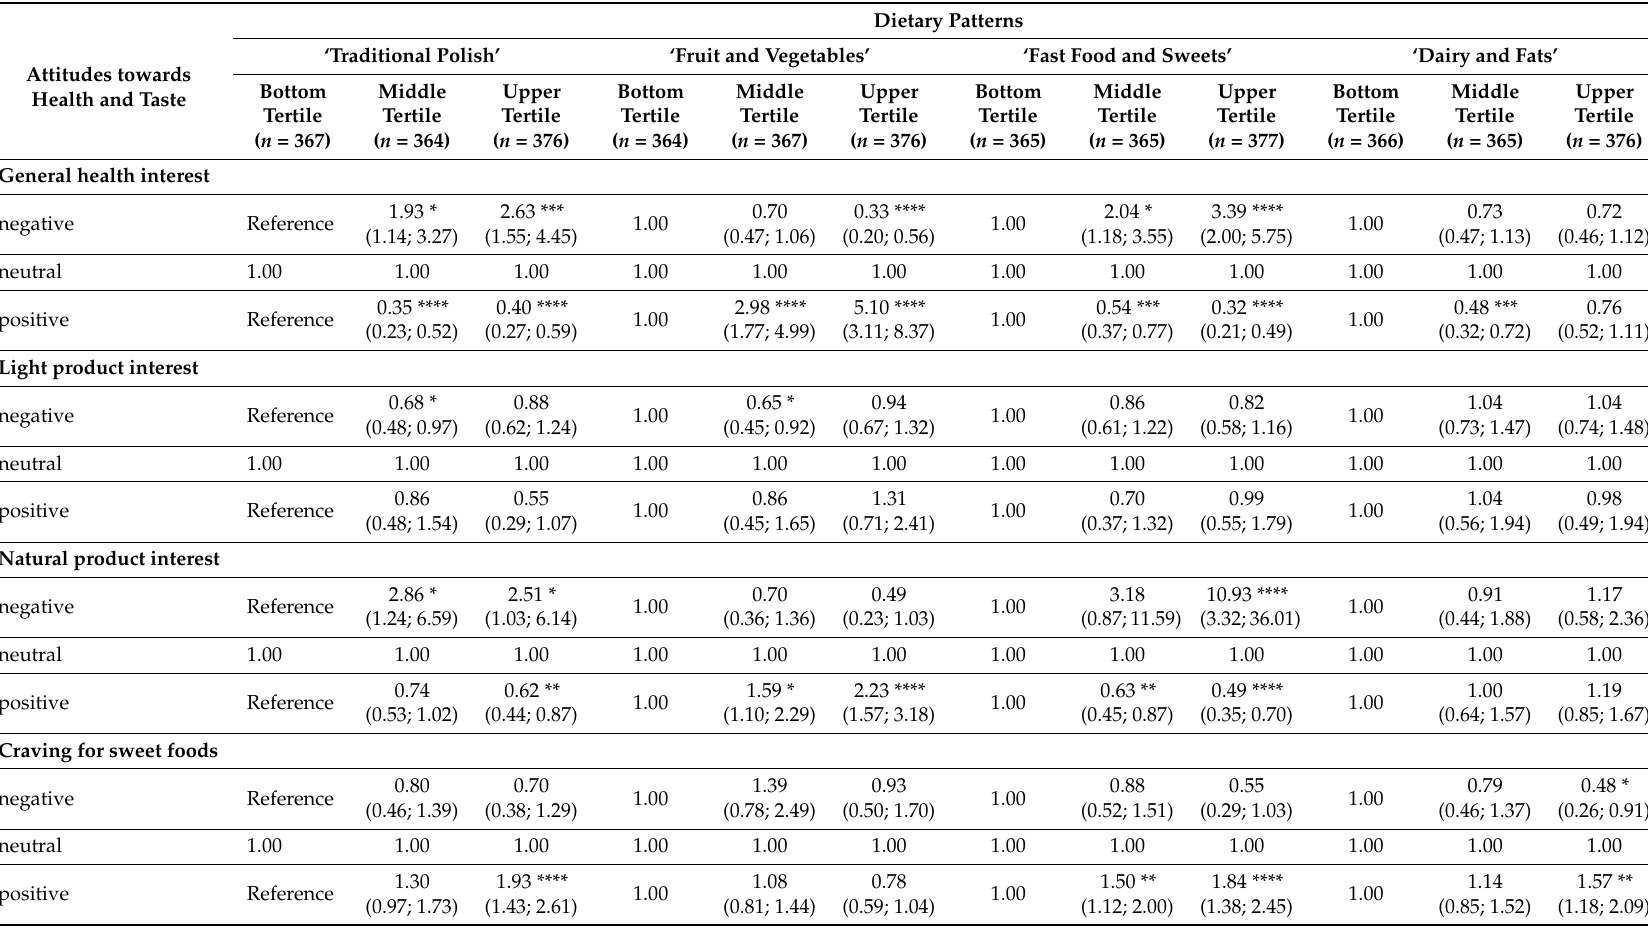
Table 3. Adjusted odds ratios (OR; 95% CI) for dietary patterns depending on attitudes towards health and taste in girls and young women in the GEBaHealth Study ( n = 1107) †